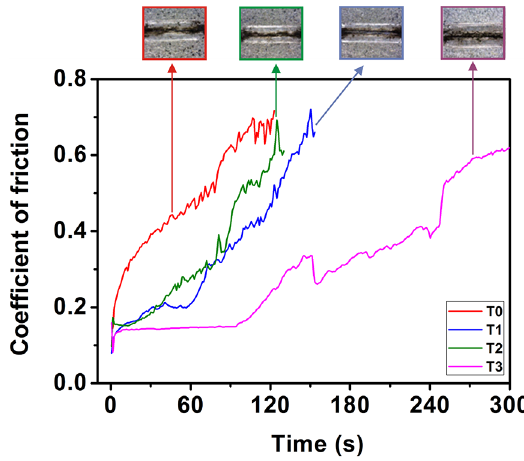
Figure 13. Coefficient of friction of the hybrid coatings